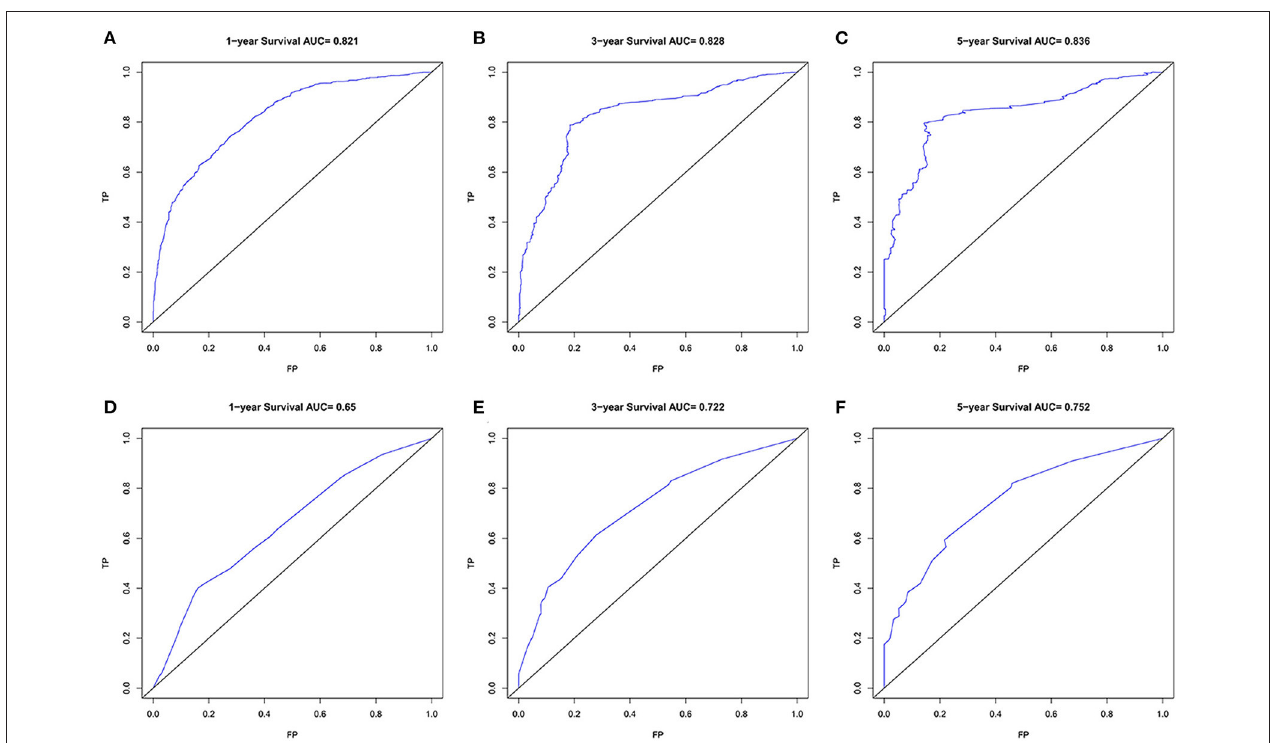
FIGURE 5 | The ROC curves of the nomogram (A–C) and the 8th AJCC TNM staging system (D–F) for 1-, 3-, and 5-year OS prediction. OS, overall survival.